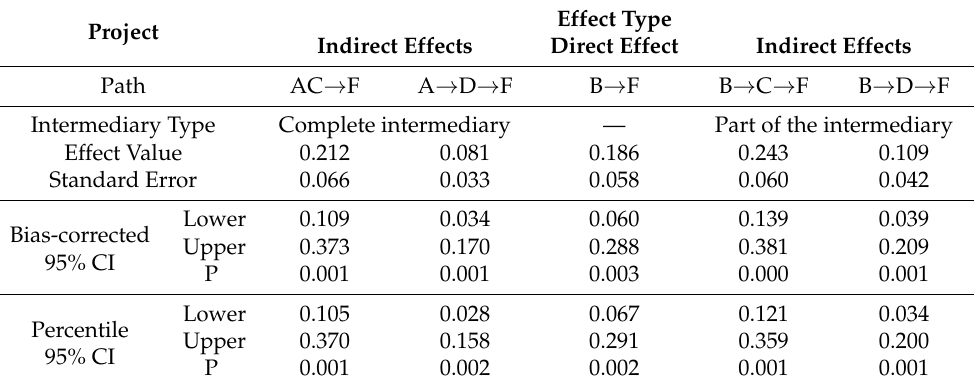
Table 4. Standardized mediation